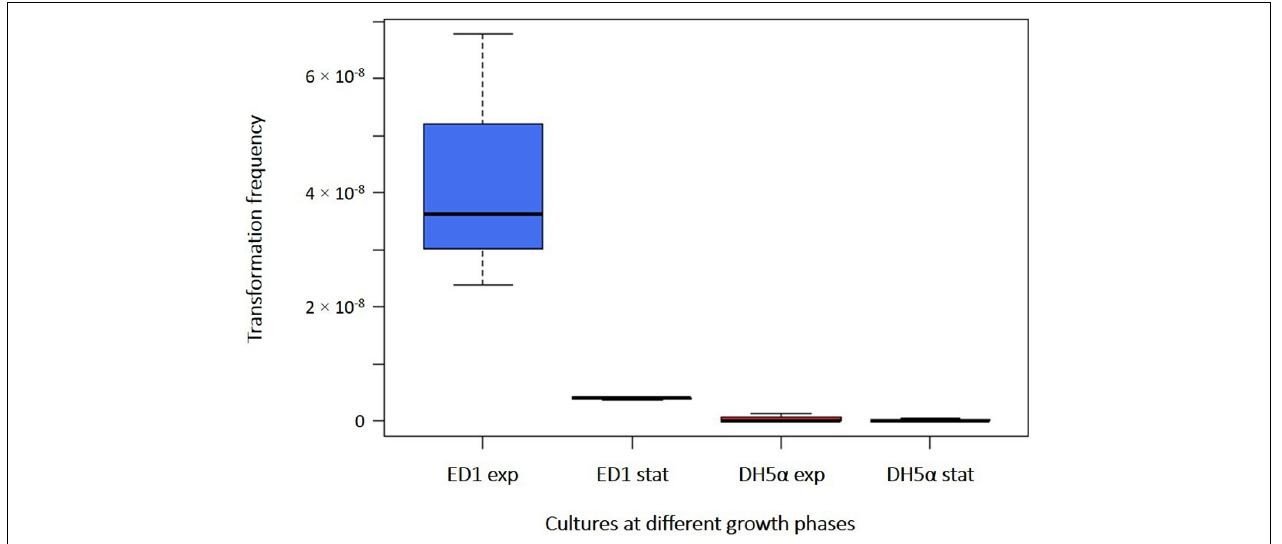
FIGURE 1 | Transformation frequencies of E. coli strains ED1 and DH5 α with cells collected at early exponential (“exp”) and stationary (“stat”) phases. Transformations were performed in Milli-Q water with 2 µ g of plasmidic DNA.